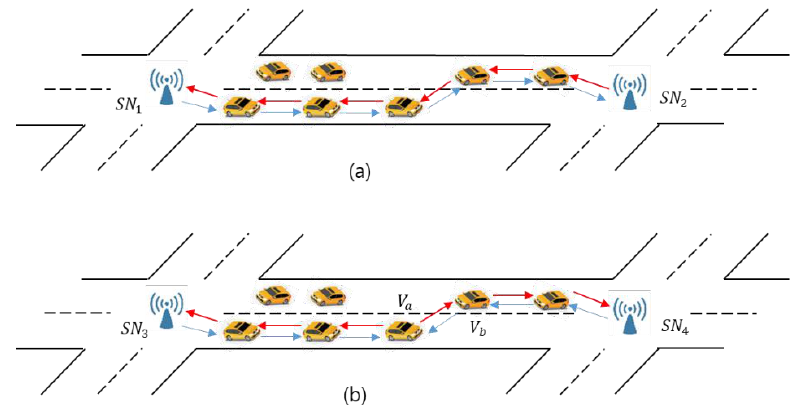
Figure 2. (a) Single link path is establishing; (b) Two link paths are establishing from different